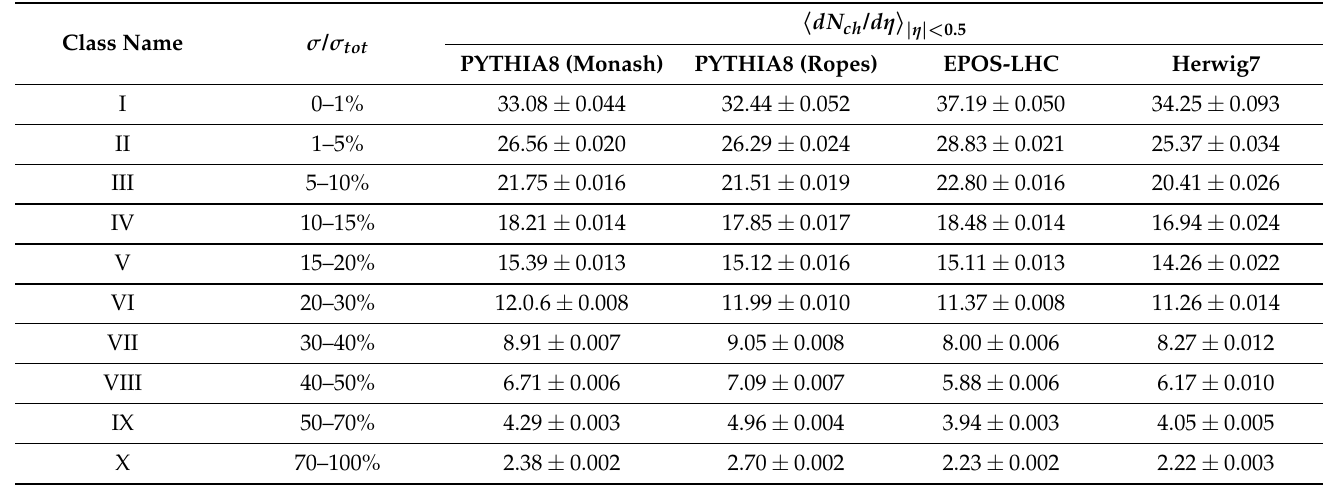
Table 2. Event multiplicity classes, their corresponding fraction of the cross-section ( σ / σ tot ) and < 0.5) for PYTHIA8 (Monash), PYTHIA8 (Ropes), dN ch / d η η their corresponding at midrapidity ( (cid:104) (cid:105) | | EPOS-LHC, and Herwig7 at √ s = 27